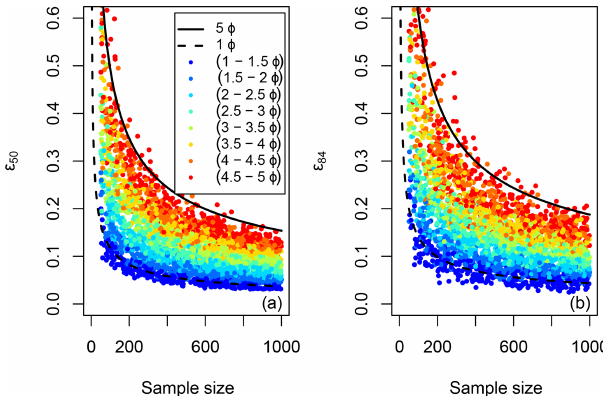
Figure 10. Estimated uncertainty for estimates of D 50 (a) and D 84 (b) are plotted against sample size. Curves were generated for bed surface samples collected by BGC Engineering and students from The University of British Columbia (unpublished data) and those published by Kondolf et al. (2003), Bunte and Abt (2001a), and Bunte et al. (2009). Vertical lines highlight the range of uncer- tainties for sample sizes of 200 and 500 stones.